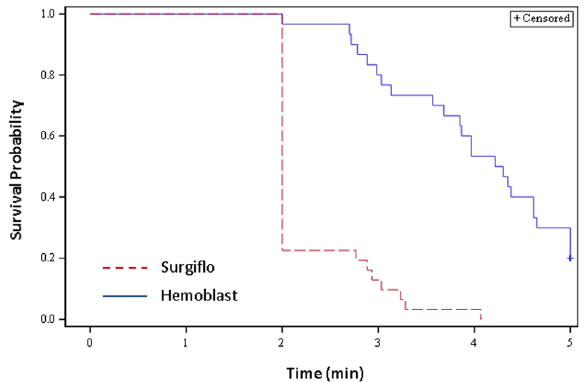
Fig. 4 Product-Limit Survival Estimates (Kaplan – Meier [KM] curves).